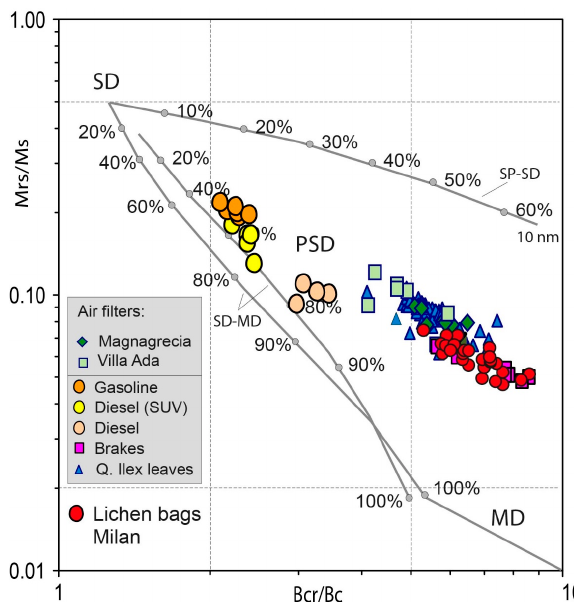
Figure 4. Bilogarithmic Day plot of the hysteresis ratios Mrs/Ms vs. Bcr/Bc for transplanted lichens Evernia prunastri (red dots) compared with Quercus ilex leaves from high traffic areas of Rome (green triangles) [30], air filters from monitoring stations in Rome (green diamonds and squares) [31], different kinds of fuel exhausts (orange, yellow and pink dots) and brake dusts (purple squares) [32]. The SD (single domain), PSD (pseudo-single domain) and MD (multidomain) fields and the theorethical mixing trends for SD-MD and SP-SD pure magnetite particles (SP, superparamagnetic) are taken from Dunlop [19,20]. Modified after [32]. FORC diagrams (Figure 5) were made for two samples (11 and 20), selected for their relatively intense magnetic properties; the distribution peaked close to the origin of the diagram and was dominated by viscous components of magnetization, typical for MD grains, without the asymmetrical features which usually suggest the presence of SP ultrafine particles. The two FORC diagrams are substantially identical, confirming that the samples contain variable concentrations of alike magnetic particles.